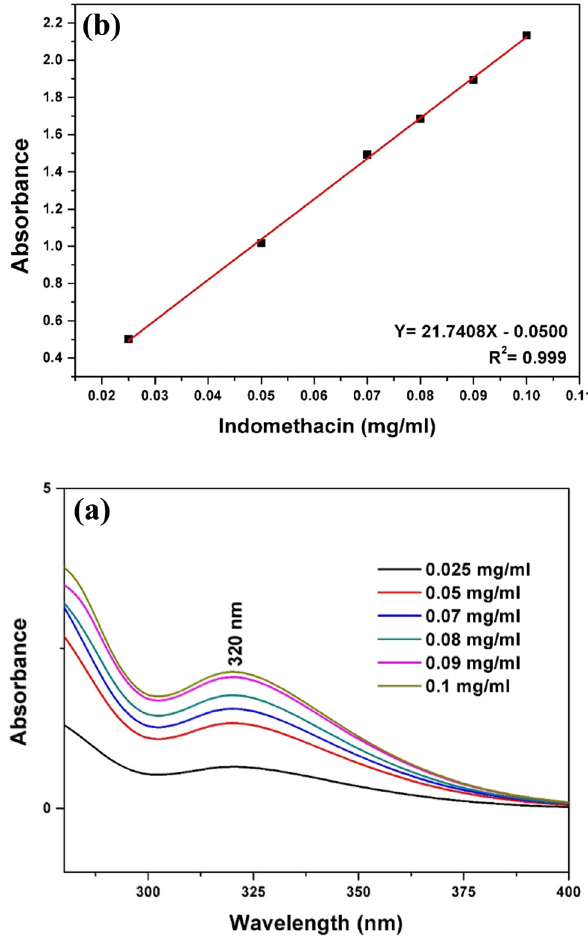
Figure 1: ( a ) Typical UV absorption spectra as a function of IDM in water and ( b ) the standard calibration curve using the absorbance values at 320